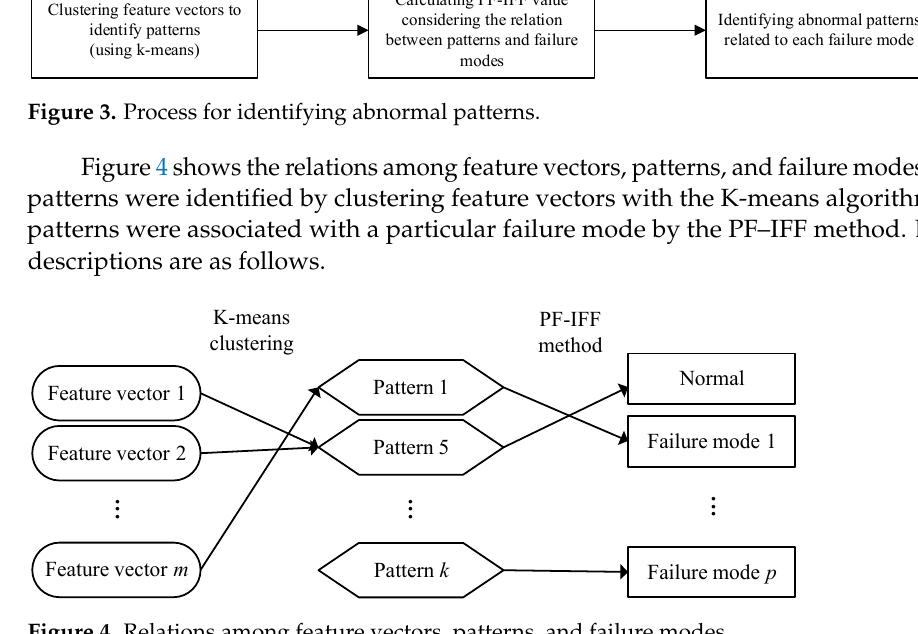
Figure 4. Relations among feature vectors, patterns, and failure modes.